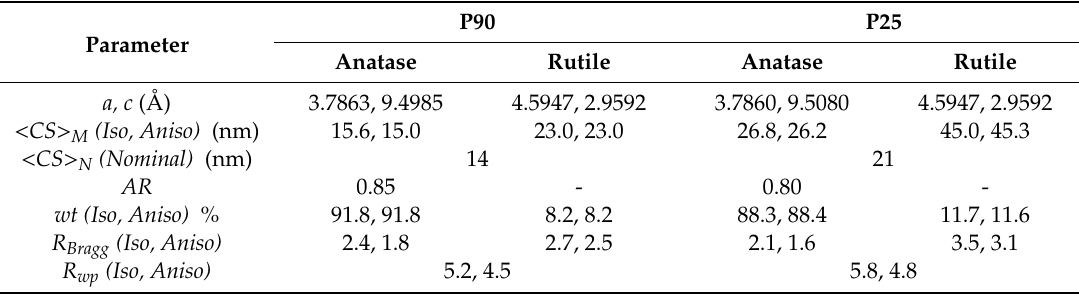
Table 1. Synoptic results of the conventional Rietveld refinement approach to size / shape determination, obtained by TOPAS according to an isotropic ( Iso ) and anisotropic ( Aniso ) morphological description of anatase. A single isotropic Debye–Waller factor was refined for all atoms in P25 (B = 0.53 or 0.49 Å 2 ) and P90 (B = 0.58 or 0.51 Å 2 ; for the Iso and Aniso models, respectively). < CS > = average crystal size; M and N subscripts = mass and number